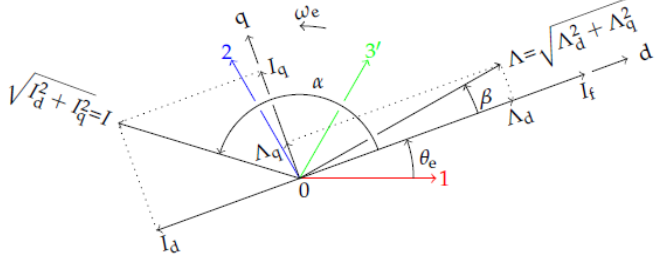
Figure 1. Wound-field flux modulation machine (WF-FMM) phasor diagram as generator showing 123-phases and dq-axes relative